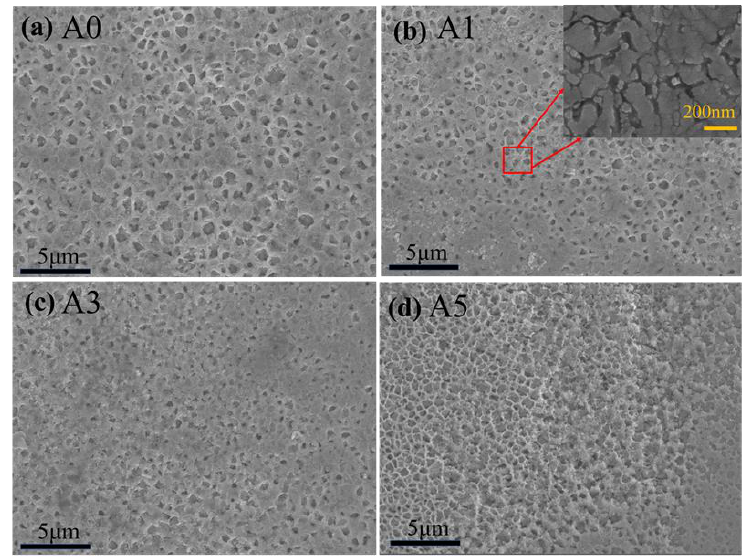
Figure 6. ( a – d ): SEM images of A0, A1, A3, A5 samples.